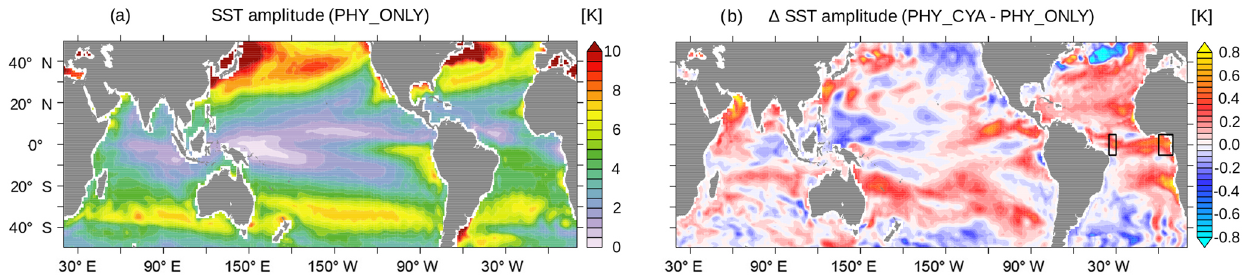
Figure 8. (a) Climatological mean amplitude of the seasonal cycle of SST (K) in PHY_ONLY. (b) Difference in the climatological mean amplitude of the seasonal cycle of SST (K) between PHY_CYA and PHY_ONLY. The black boxes display the locations discussed in Sect. 5 (Fig. 9).